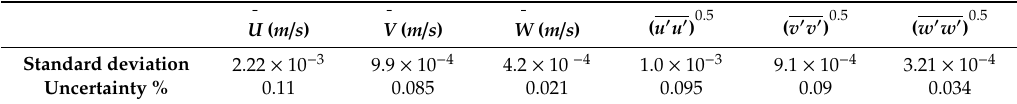
Table 2. Uncertainty associated with Acoustic Doppler Velocimeter (ADV) data.